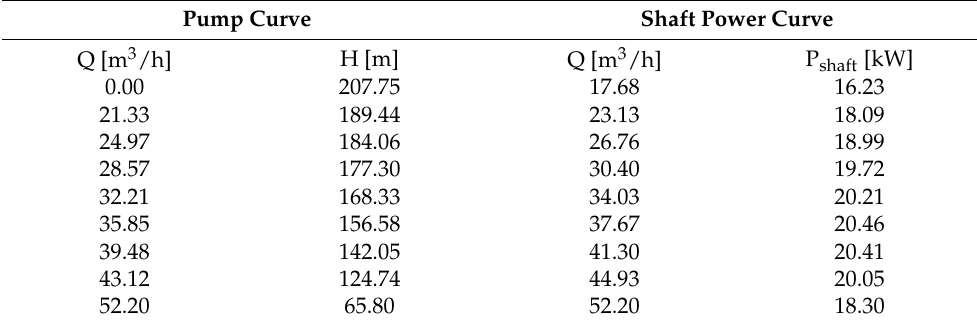
Table 1. Input data for PV pump.